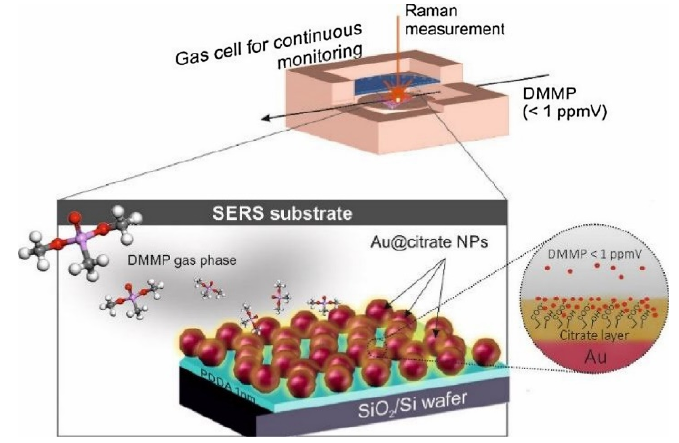
Figure 11. Interaction of dimethyl methyl phosphonate (DMMP) with an SERS-based sensor. Republished with permission from [98]; permission conveyed through Copyright Clearance Center, Inc.